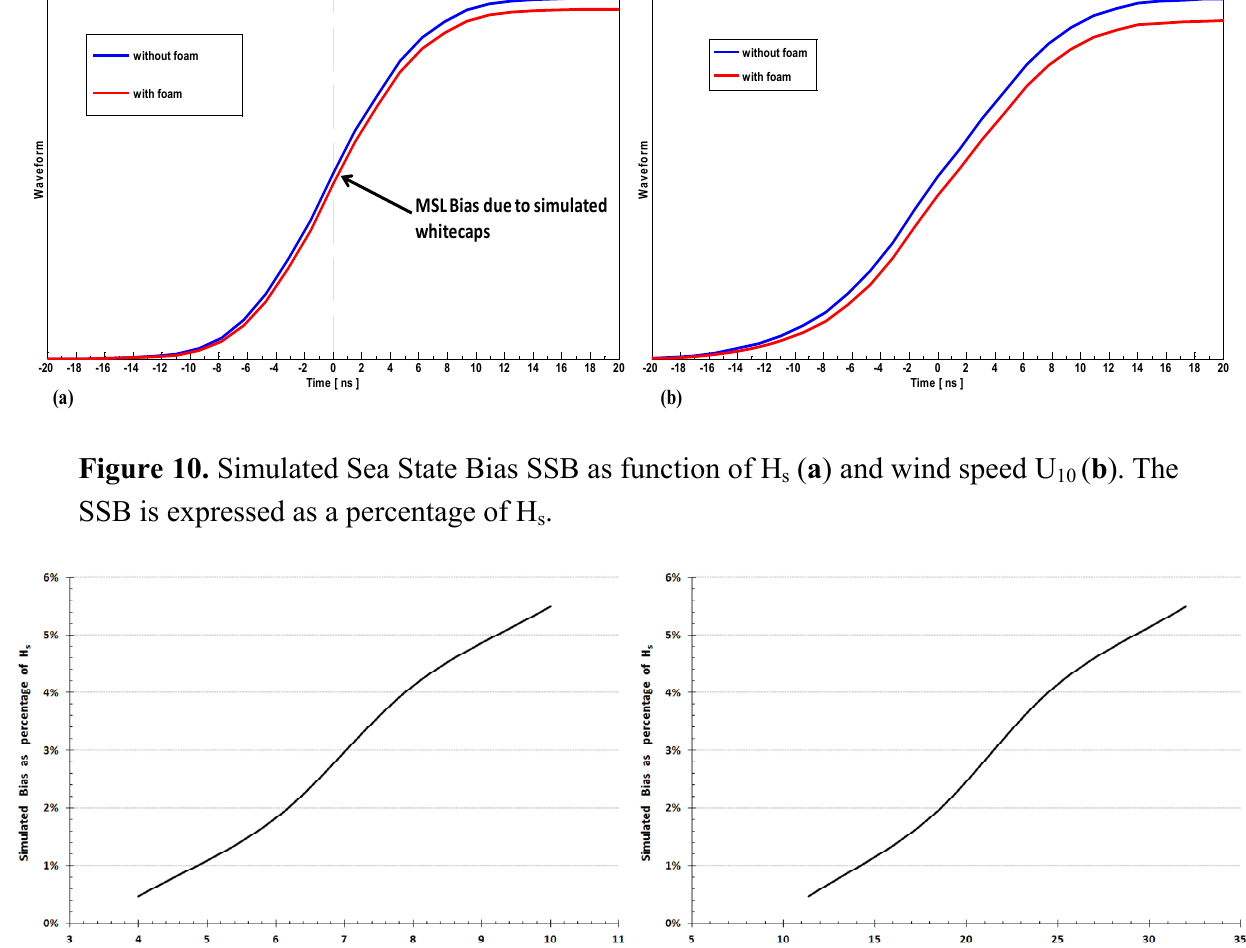
Figure 9. Simulated altimeter waveform with foam (red curve) and without foam (blue curve) for two different sea state conditions: ( a ) H